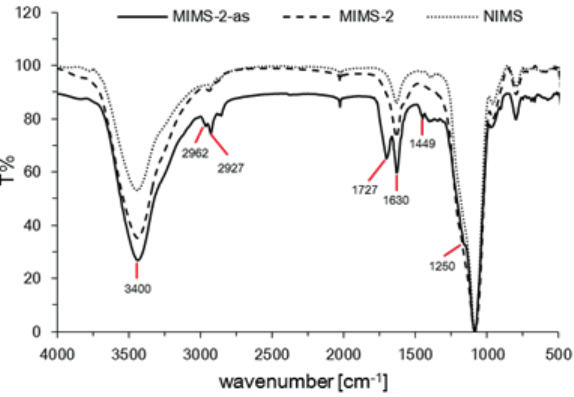
Figure 1: FT-IR spectra of MIMS- 2 -as, MIMS- 2 , and NIMS